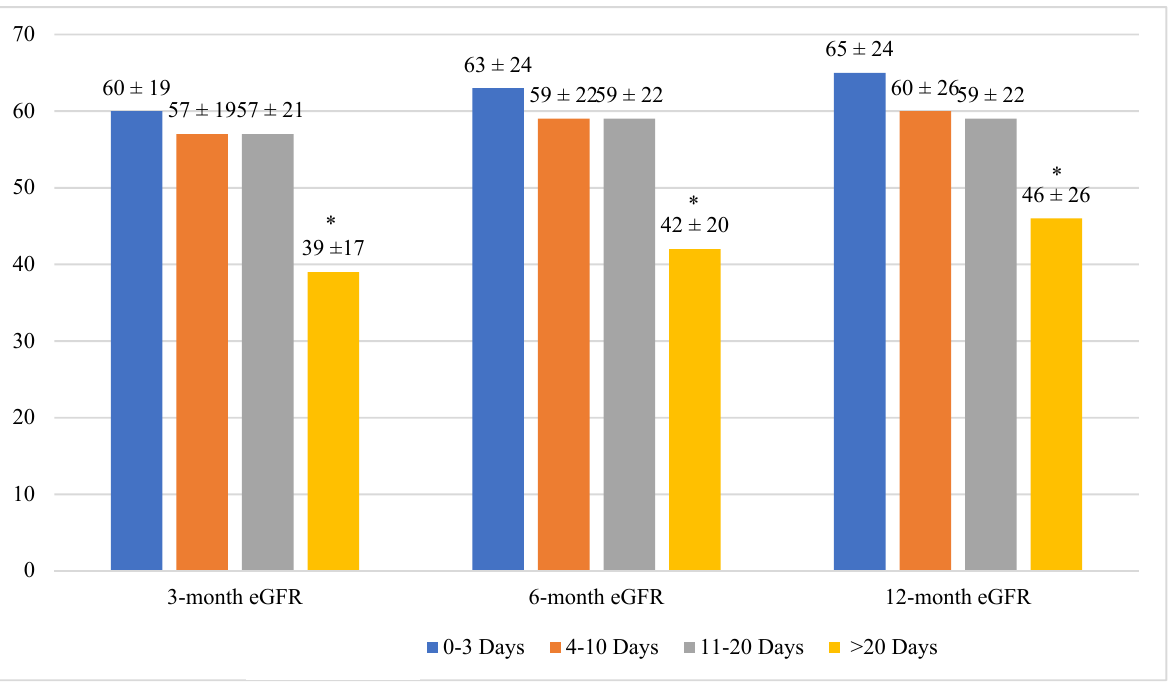
Figure 1. Mean eGFR (mL/min/1.73 m 2 ) ± SD at 3, 6, and 12 months Across DGF Duration Groups (* indicates statistical significance, p < 0.001).